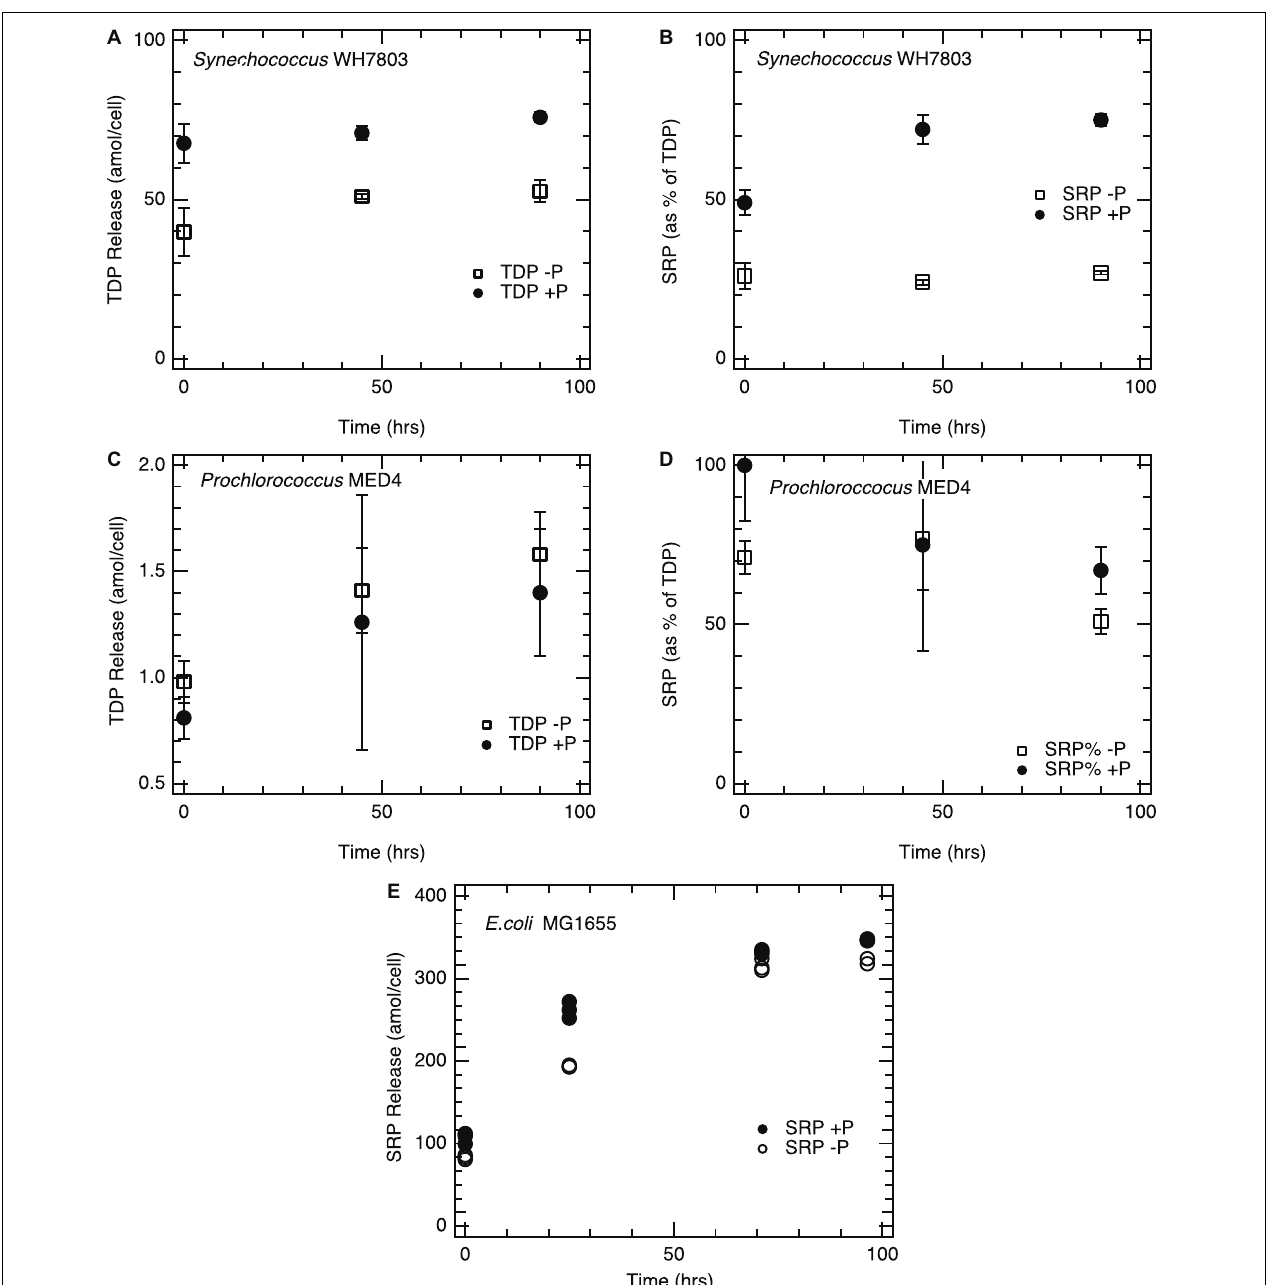
FIGURE 1 | Total dissolved phosphorus and soluble reactive phosphorus release from cell cultures following lysis. (A) Synechococcus WH7803 TDP release; (B) Synechococcus WH7803 fraction of TDP as SRP; (C) Prochlorococcus MED4 TDP release; (D) Prochlorococcus MED4 fraction TDP as SRP. (E) SRP regeneration in E. coli incubations normalized to cell density. Open symbols represent lysates from P-deplete cells, filled symbols represent lysates from P-replete cells. All points represent the mean of triplicate measurements and error bars the standard deviation. Synechococcus WH7803 and Prochlorococcus MED 4 phosphorus replete and deplete conditions are statistically significant in the figures above; p < 0.01 and p < 0.1 after initial release,